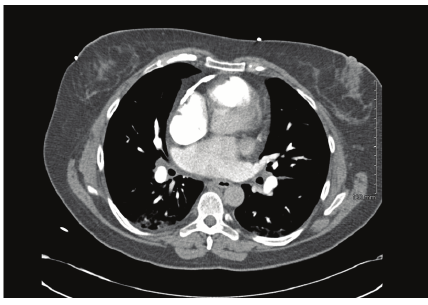
Figure 1: CT scan of chest showing pericardial calcifications.